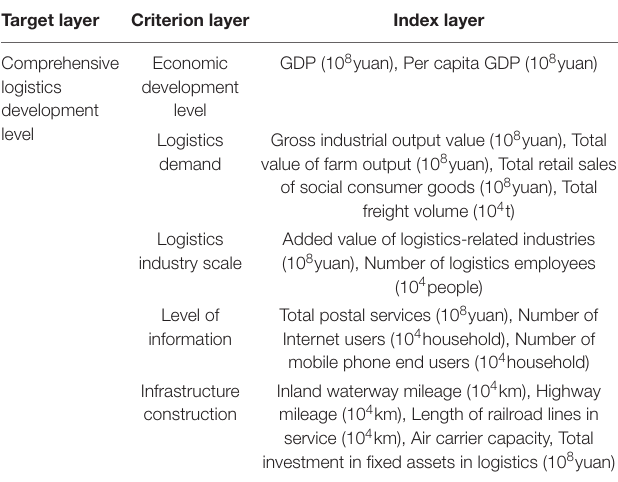
TABLE 1 | Regional logistics industry comprehensive development-level index system.